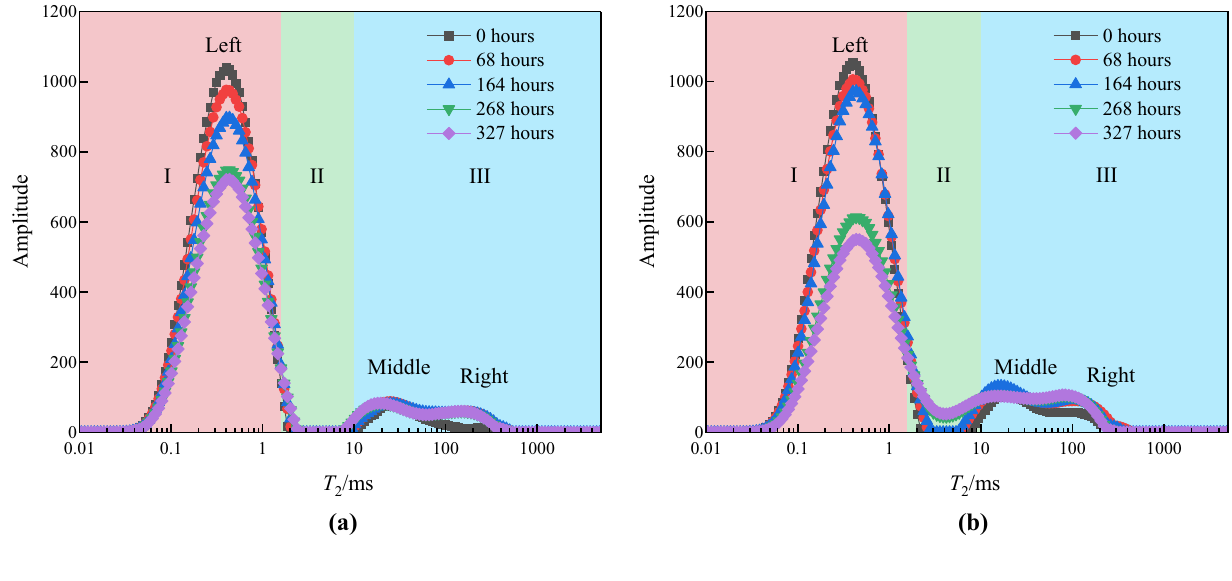
Fig. 5 NMR T 2 spectra of fracturing fluid SI: a Sample F; b Sample